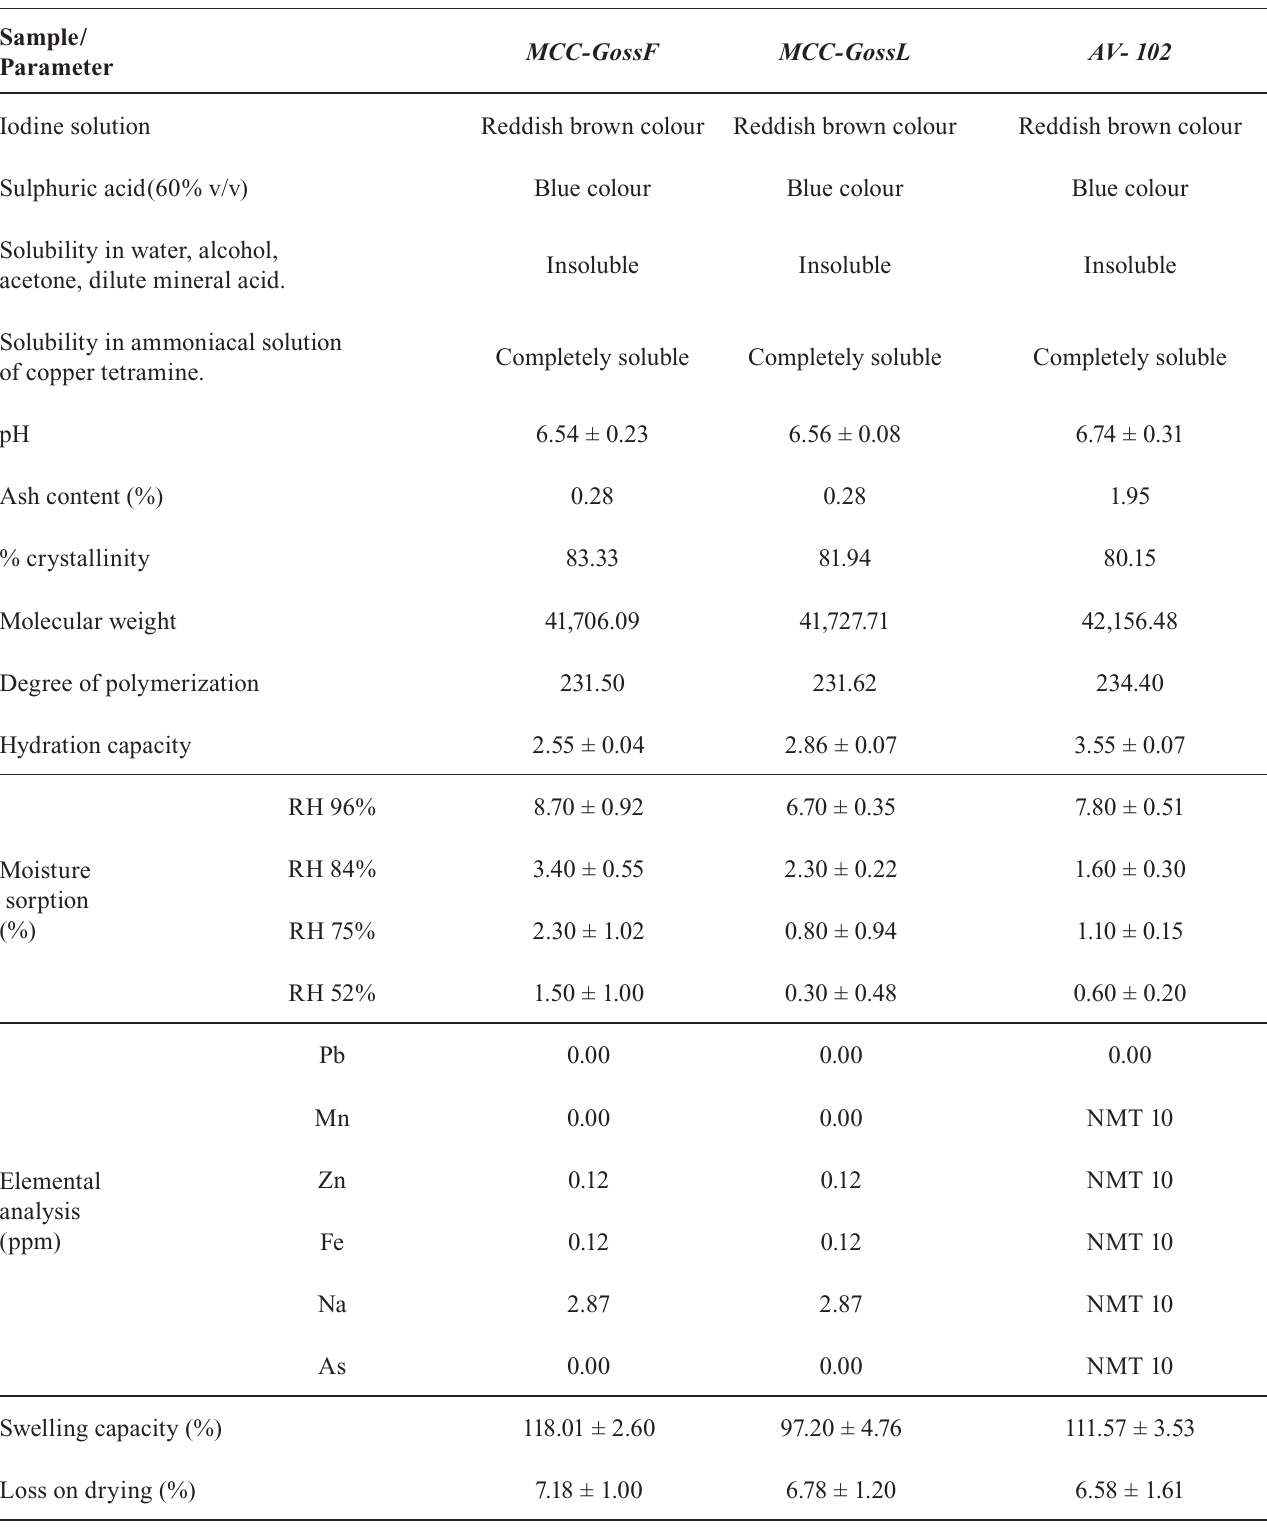
TABLE I - Some physicochemical properties of MCC-GossF, MCC-GossL and AV-102